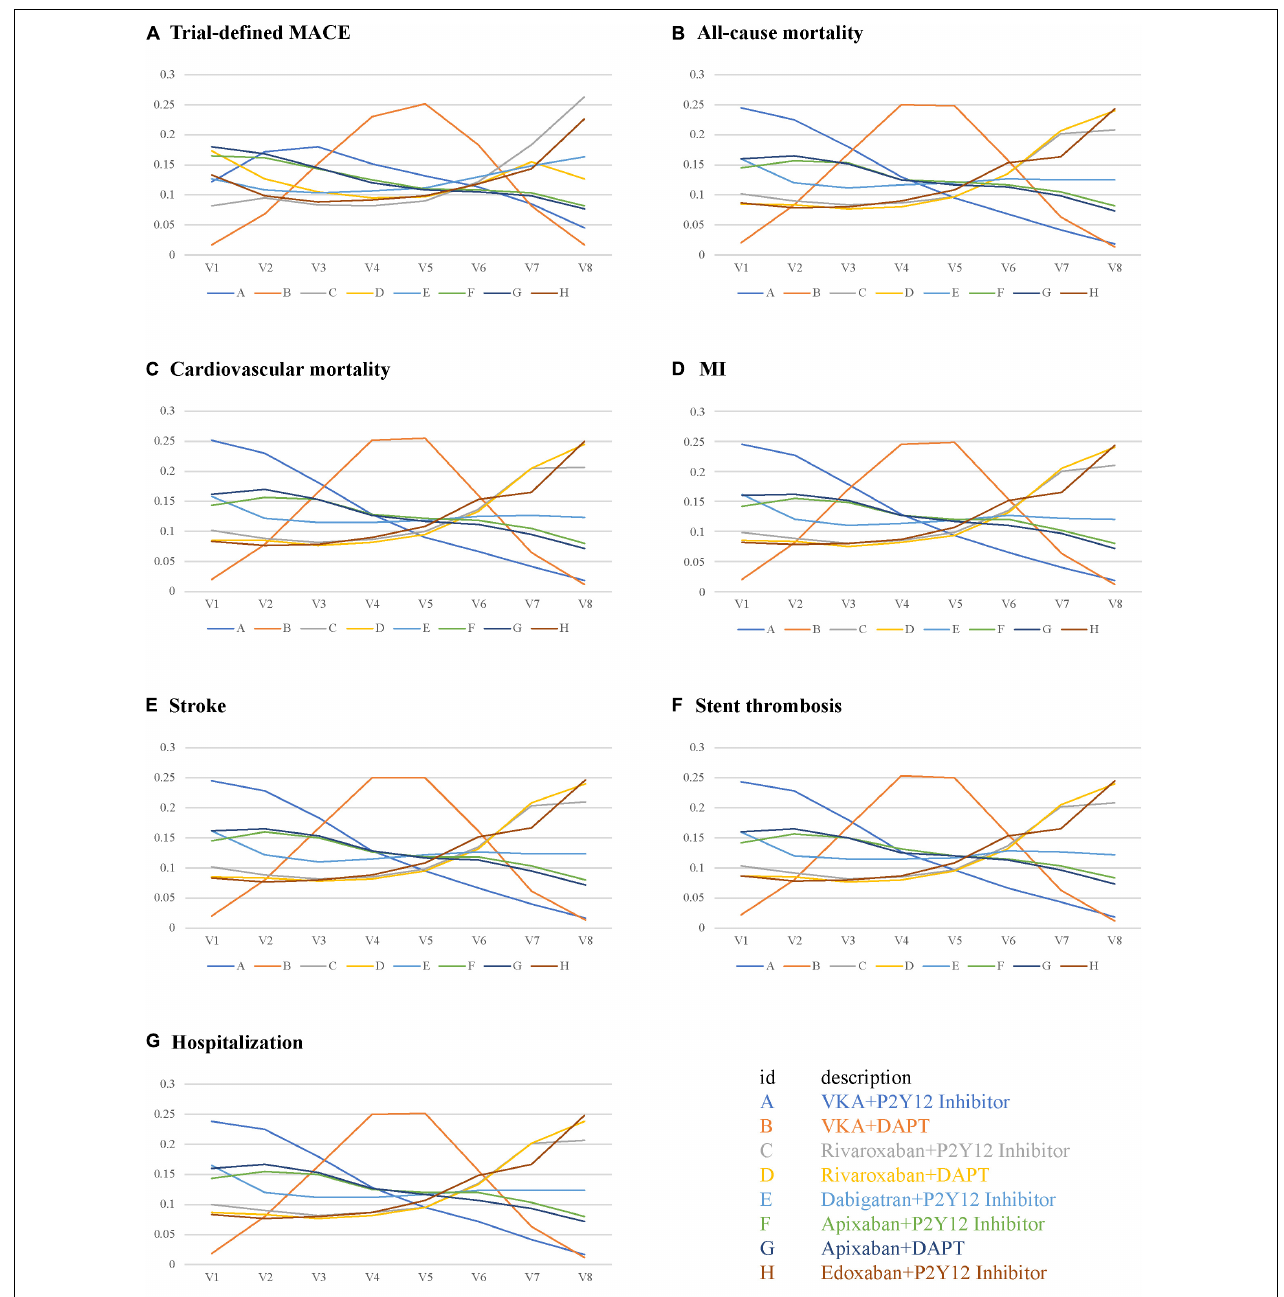
FIGURE 7 | Rank probabilities for efficacy outcomes. (A) Trial-defined MACE. (B) All-cause mortality. (C) Cardiovascular mortality. (D) MI. (E) Stroke. (F) Stent thrombosis. (G)